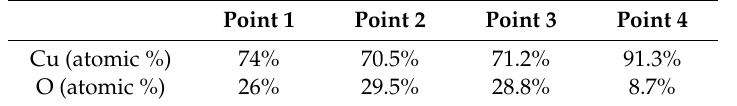
Figure 5. EDS analytical points on the high-curvature morphologies of Cu. Table 1. The atomic percentage of copper and oxygen elements on high-curvature morphologies.